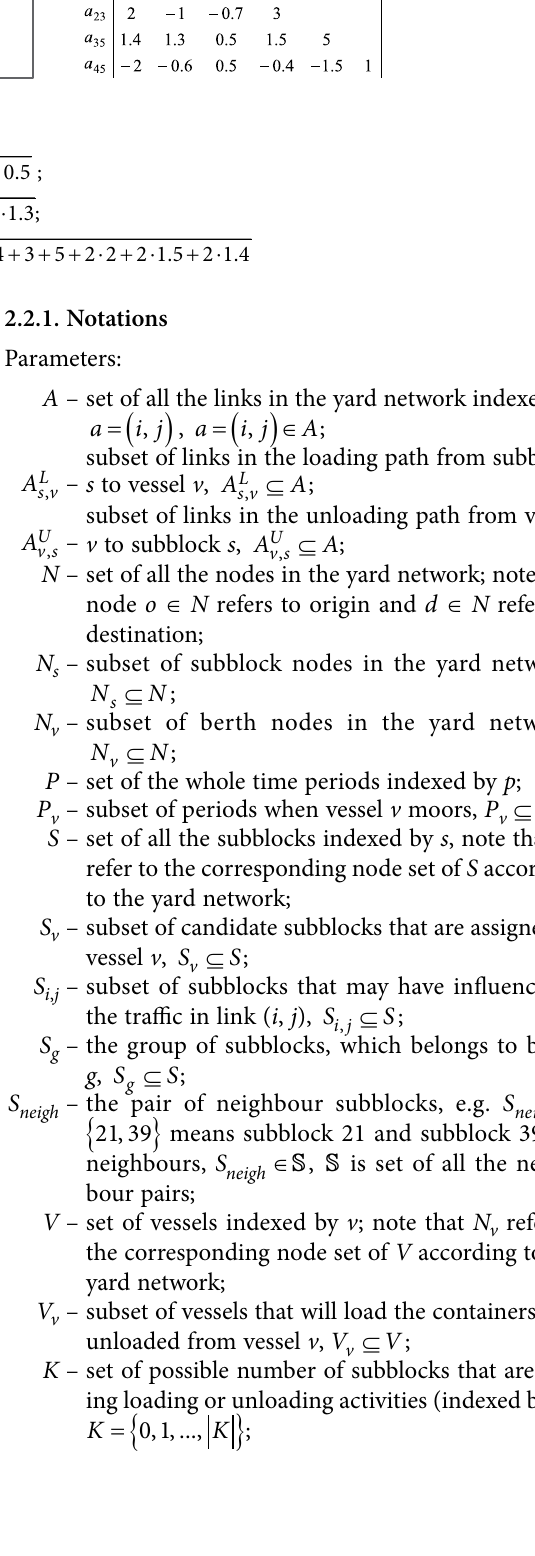
Figure 4. An illustrative